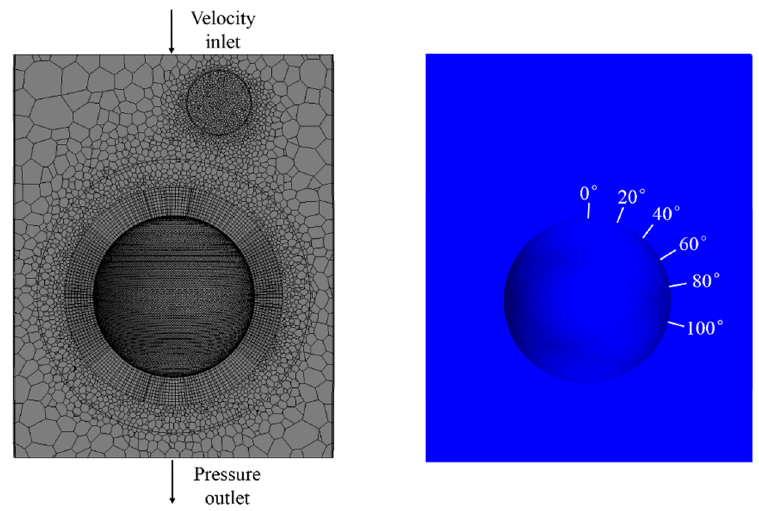
Figure 1. Mesh plot of 3D verification model and different measuring positions.